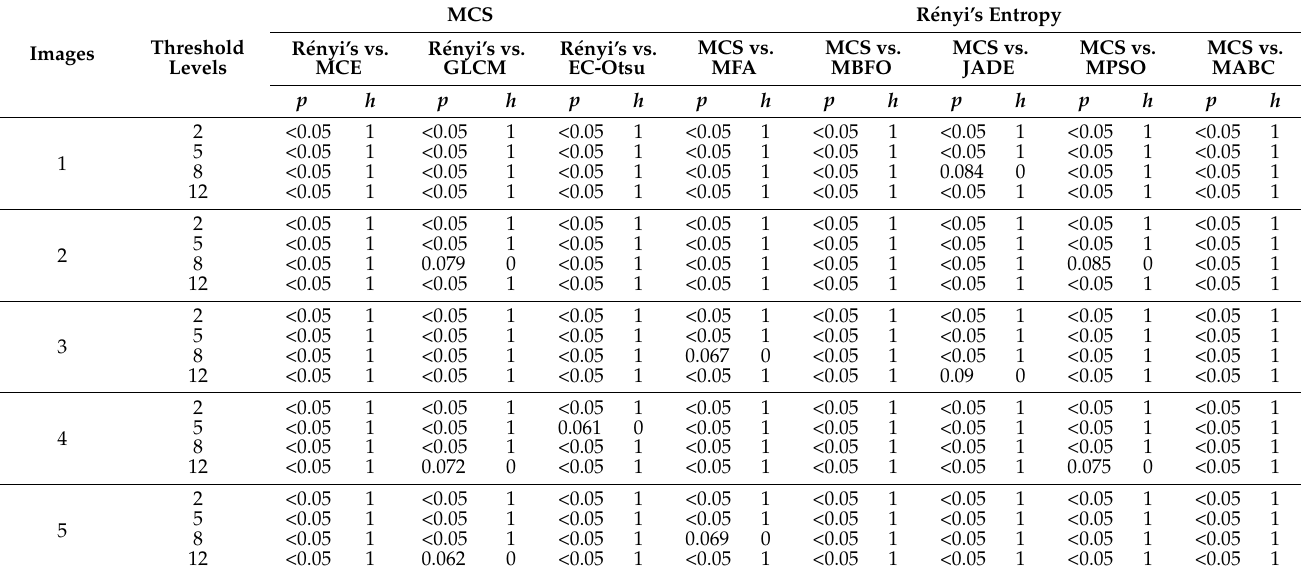
Table 12. Statistical analysis (Wilcoxon rank sum test) of 20 runs for each of the 20 independent samples for the